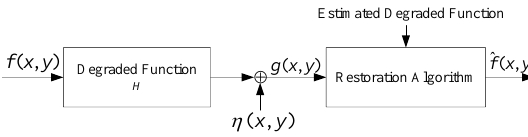
Figure 7. Degradation and restoration model of image.